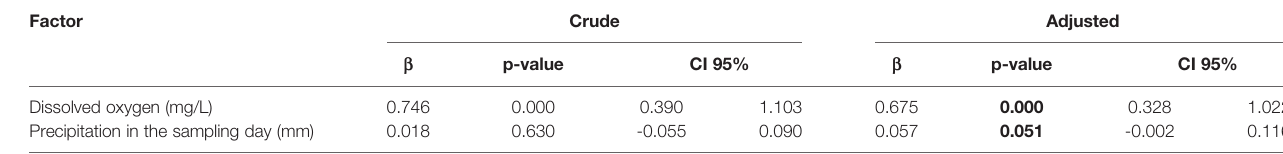
TABLE 3 | Model 2. Factors related to the abundance of bla KPC in the WWTP during the study time. Factor